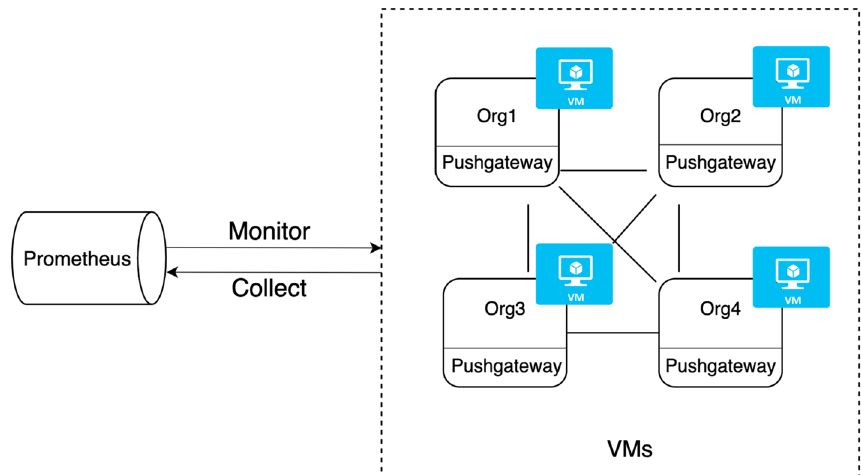
Fig. 1 The monitor component and a DApp in cloud